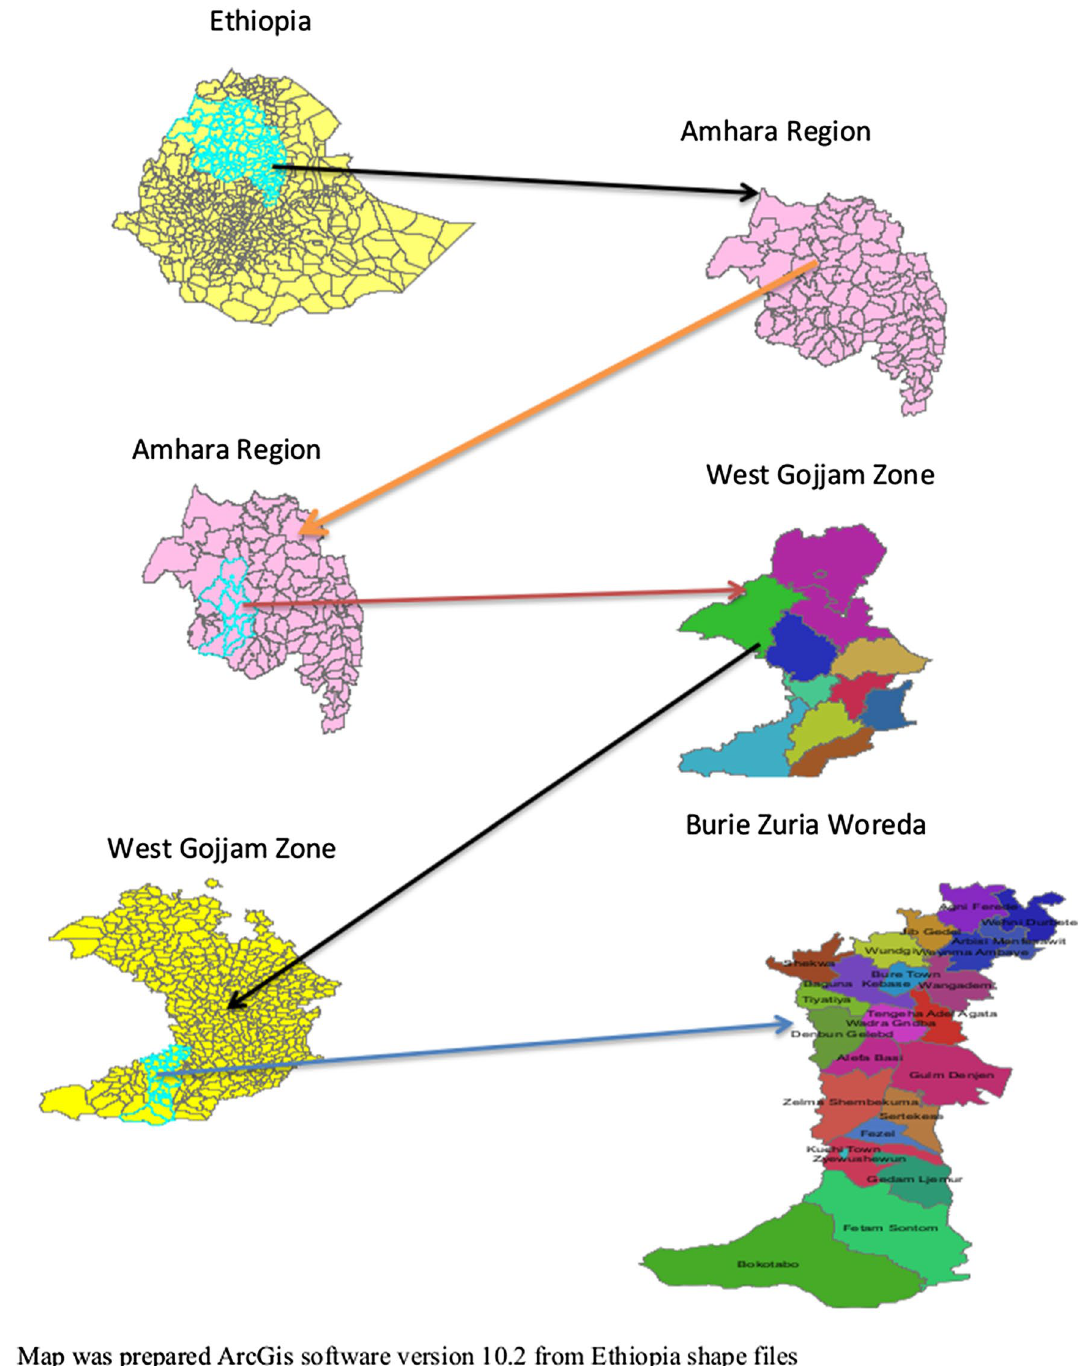
Figure 1. Map of Bure Zuria district which prepared ArcGis software version 10.2 from Ethiopia shape